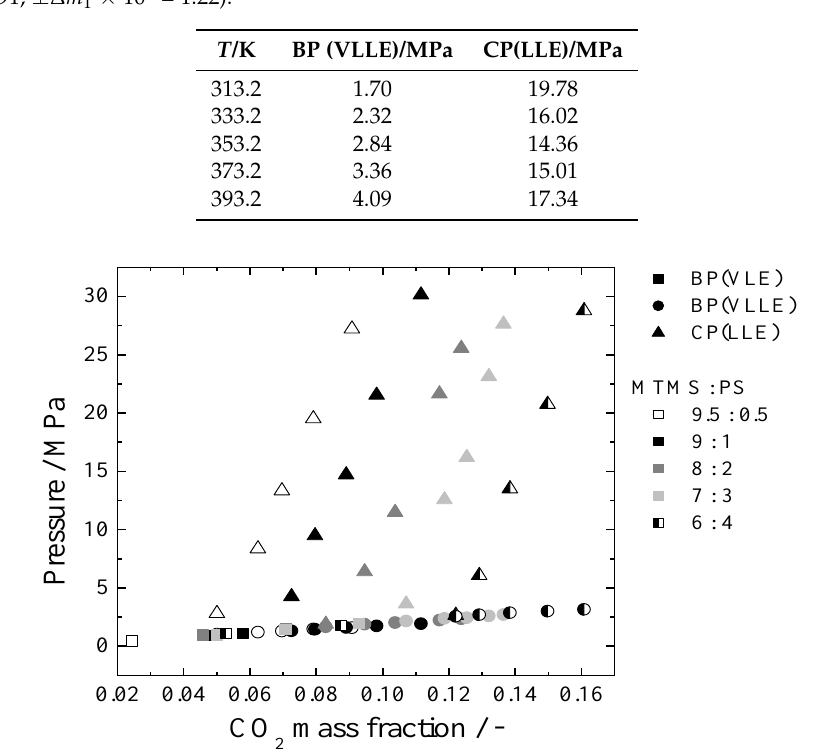
Table 5. Experimental data for a CO 2 (1)/MTMS(2)/PS(3) system (M W = 35,000, m 1 = 0.094, m 2 = 0.815, m 3 = 0.091, ±Δ m 1 × 10 3 = 1.22).